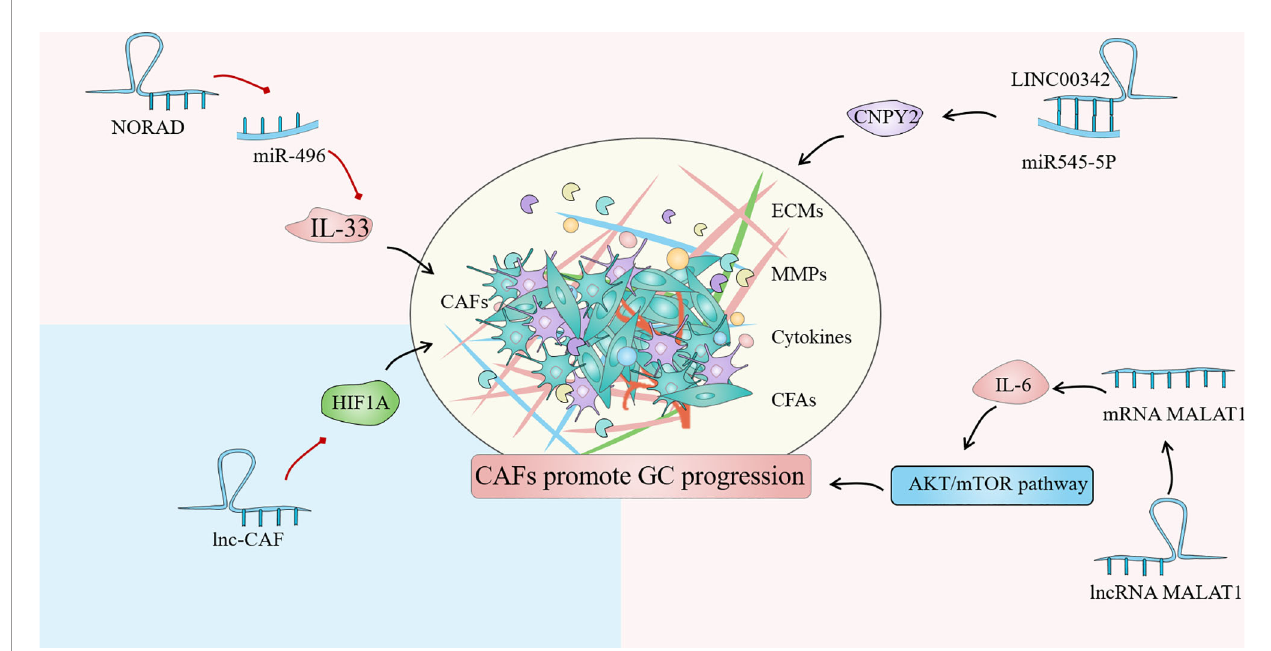
FIGURE 4 | Cancer associated fi broblasts (CAFs) are one of the most common stromal cells in the gastric cancer (GC) immune microenvironment (TIME). The degree of invasion of CAFs in tissues is closely related to poor clinical prognosis. The regulation of lncRNA in GC-related CAFs is mainly manifested in the regulation of tumor cell autophagy, expression of HIF family genes, fi broblast growth factor and in fl ammatory factor